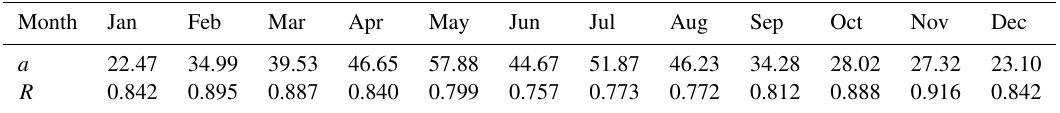
Table 2. Monthly regression statistics of SSR vs. SD anomalies (see Eq. 1).